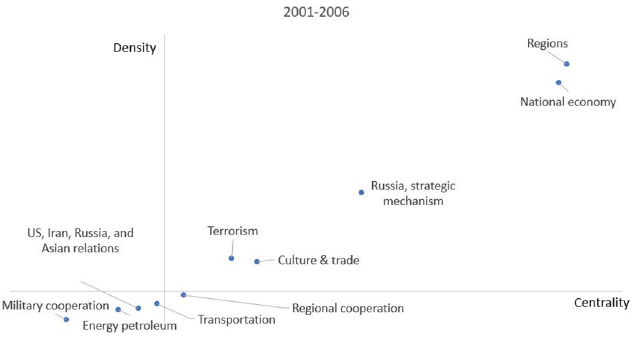
Fig 6. Strategic diagram between 2001 and 2006.